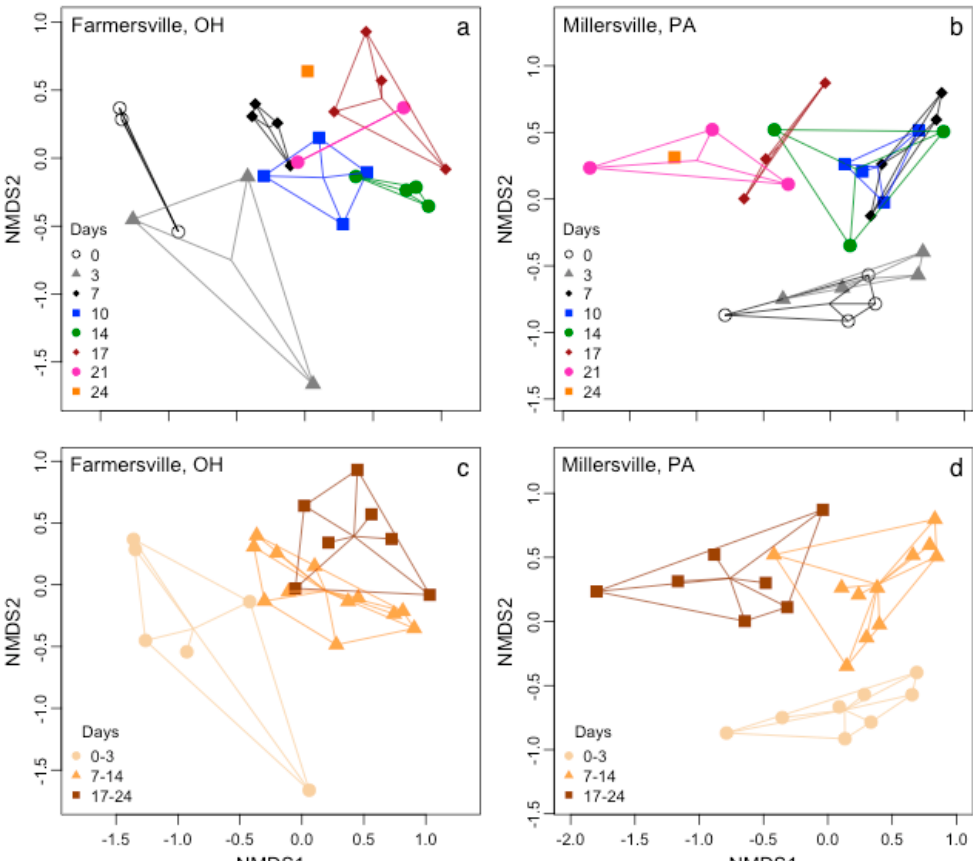
Figure 3. Succession of ( a ) and ( c ) Farmersville, OH (3-D, R 2 = 0.98, stress = 0.14) and ( b ) and ( d ) Millersville, PA (3-D, R 2 = 0.99, stress = 0.11) epinecrotic biofilms were depicted with NMDS ordination using the ( a ) and ( b ) days of decomposition and ( c ) and ( d ) binned categories as an overly with convex hulls and spider lines that connect at the group midpoint. Groups for both communities were significantly different as determined by PERMANOVA.